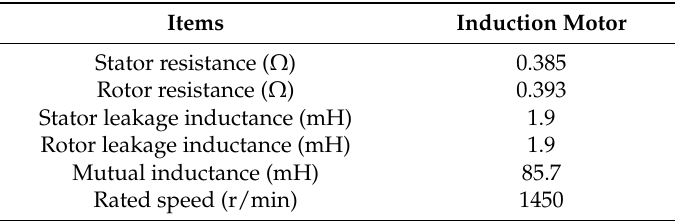
Figure 8. Experimental platform of the DPF-WECS. Table 3. Parameters of the IM for the imitation of the wind turbine.